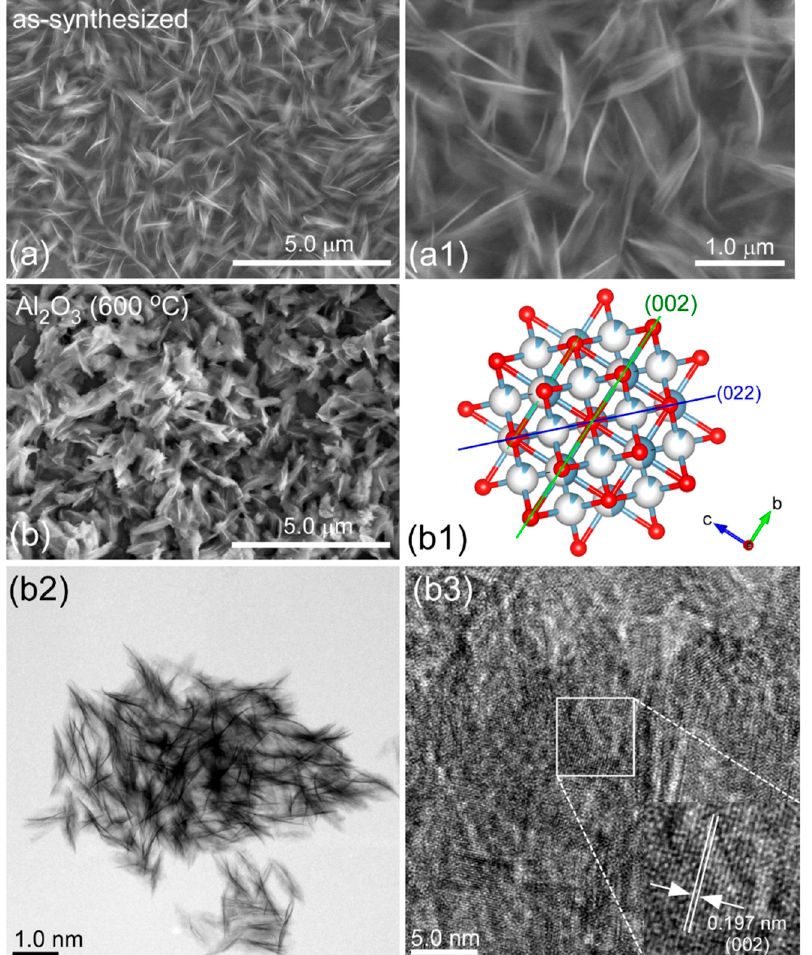
Figure 1. Scanning electron microscope (SEM) ( a , a1 , b ), transmission electron microscope (TEM) ( b2 ), high resolution TEM ( b3 ) images of the as-synthesized Al-precursor ( a , a1 ) and Al 2 O 3 ( b , b2 , b3 ), and the structure projection ( b1 ) of the (002) and (022) planes for cubic phase γ -Al 2 O 3 . The BET surface areas of Ni-Al 2 O 3 and Rh-Al 2 O 3 nanosheets were measured to be 151.2 m 2 /g and 153.8 m 2 /g, respectively. The surface areas were very similar to that of bare Al 2 O 3 . This indicated that the surface area was not significantly impacted by the metal- loading.